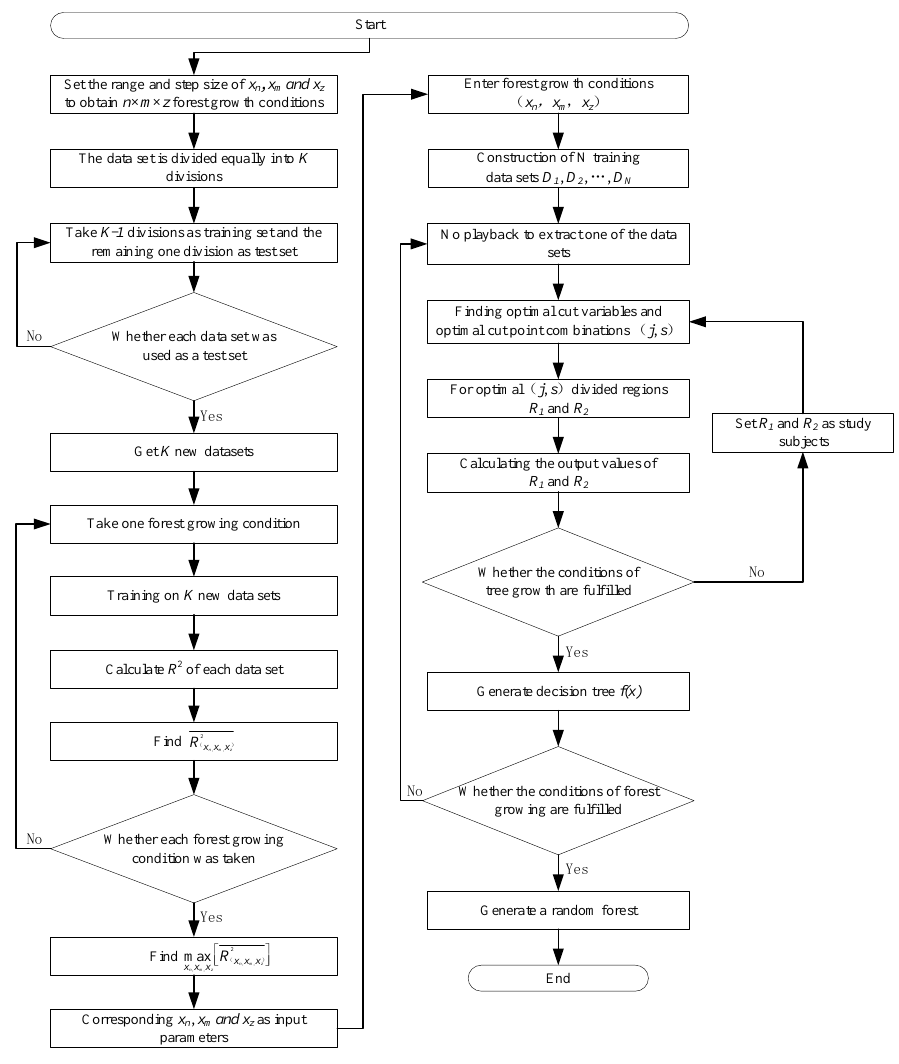
Figure 3. GSCV-RF algorithm flow chart.